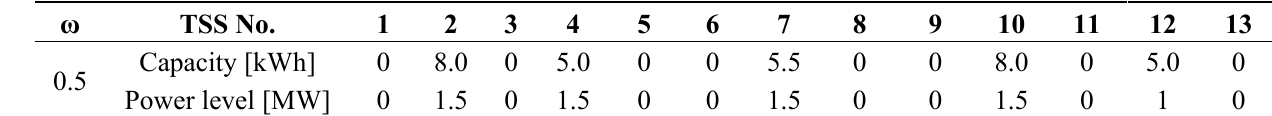
Table 7. Optimized scheme of full day.